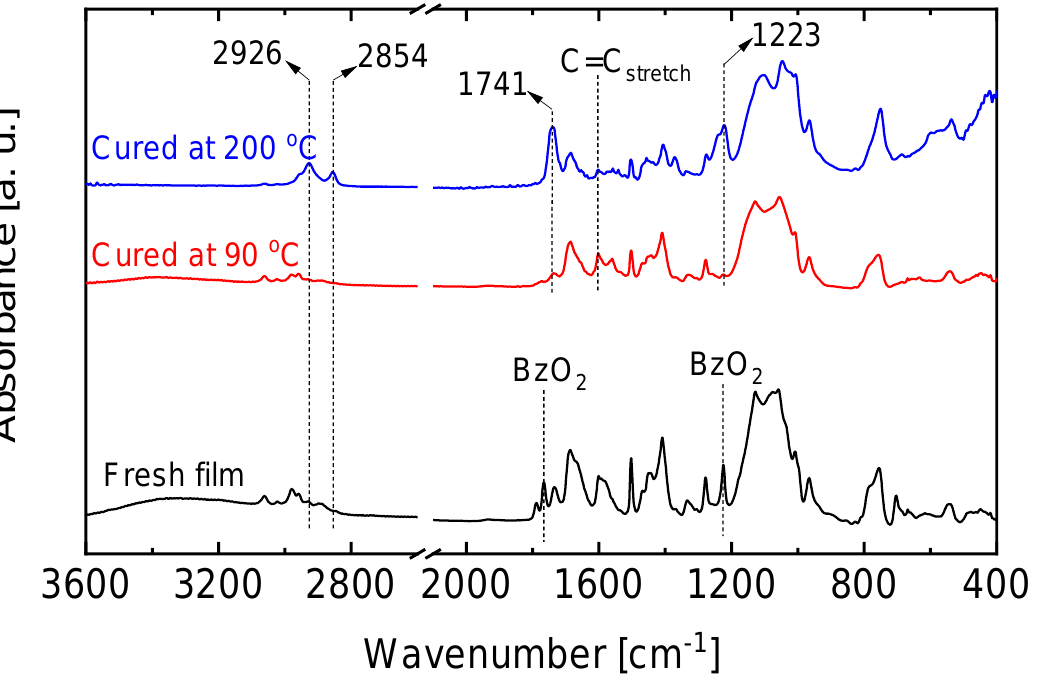
Figure 22. FTIR spectra of SiO 2 -ZrO 2 -polybenzoxazine before and after thermal curing at 90 (red line) and 200 °C (blue line). Reproduced from [111].